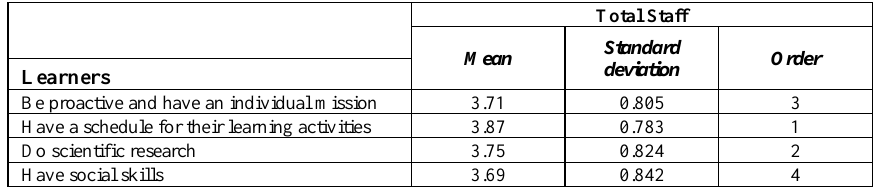
Table 3. Opinions about readiness in learners for HUST